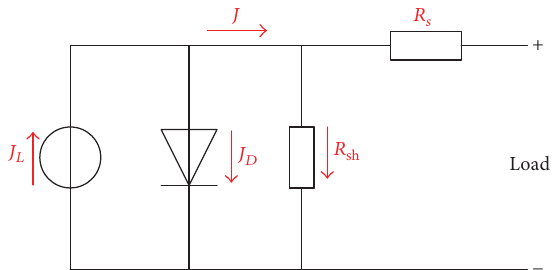
Figure 7: Equivalent circuit of the perovskite solar cell.